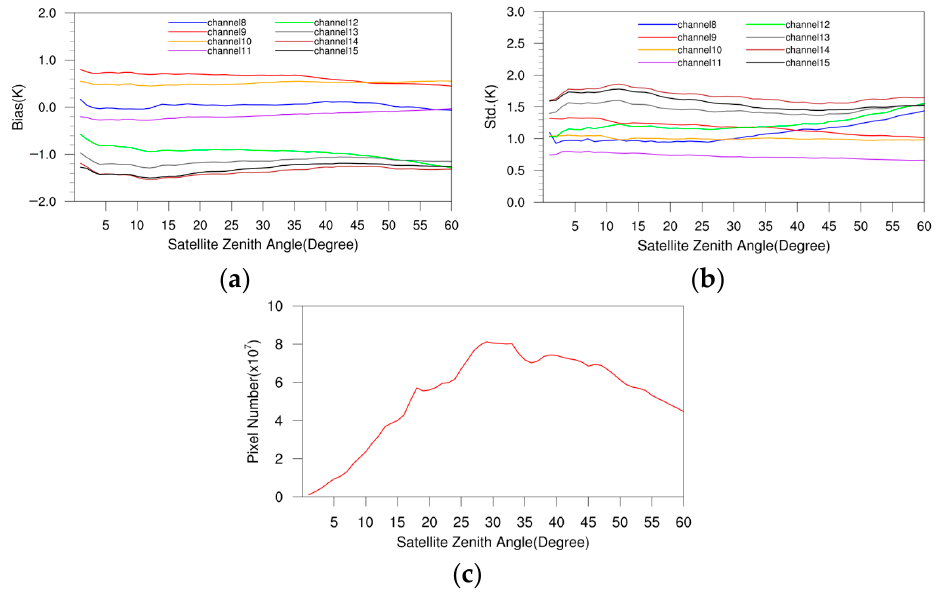
Figure 10. Biases ( a ) and standard deviations ( b ) of Fengyun-4B/AGRI IR channels’ brightness temperature observations and RTTOV simulations with respect to satellite zenith angles calculated at 1 ◦ intervals over the ocean under clear-sky conditions and with satellite zenith angles less than 60 ◦ from June to November 2022. Pixel numbers calculated at 1 ◦ intervals are shown in ( c